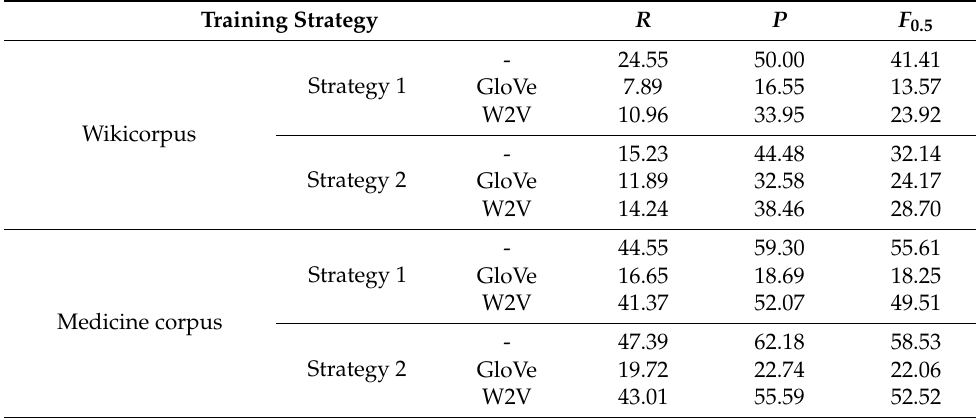
Evaluation of subject-verb concordance error correction . Models show better per- formance when trained on the medicine corpus than on the Wikicorpus (see Table 14). In the medicine corpus, the model without pretrained embedding corrected 44.55% of sentences in the training set generated using strategy 1 and 47.39% in the training set generated using strategy 2. Precision was low for both datasets (59.30% and 62.18%). The model with Word2Vec corrected 41.37% of sentences in the training set generated using strategy 1 and 43.01% in the training set generated using strategy 2, whereas the model with GloVe corrected 16.65% of sentences in the training set generated using strategy 1 and 19.72% in the training set generated using strategy 2. The results of the models in the Wikicorpus are poorer than in the medicine corpus. The model without pretrained embedding corrected 24.55% of sentences in the training set generated using strategy 1, whereas the models using GloVe and Word2Vec corrected 7.89% and 10.96%, respectively. Table 14. Recall ( R ), precision ( P ) and F 0.5 for the evaluation of subject-verb concordance error